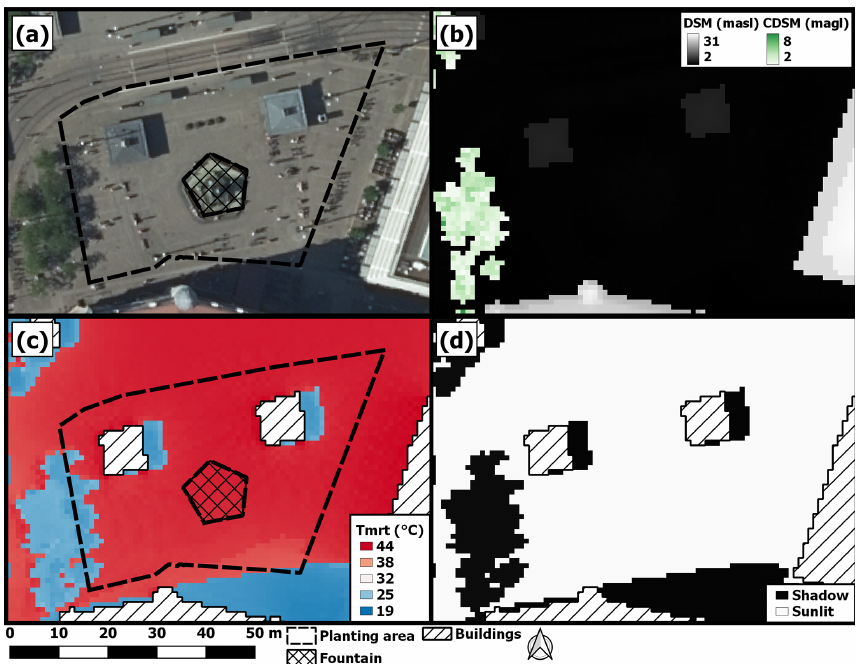
Figure 3. Map of case study area with (a) Orthophoto RGB 0.25m © Lantmäteriet (2018), where the dashed black line determines the planting area for possible tree locations and (b) DSM and CDSM. Panels (c) and (d) show examples of output from SOLWEIG, where panel (c) indicates T mrt and (d) indicates the shadow pattern for 17:00LST on 22 June